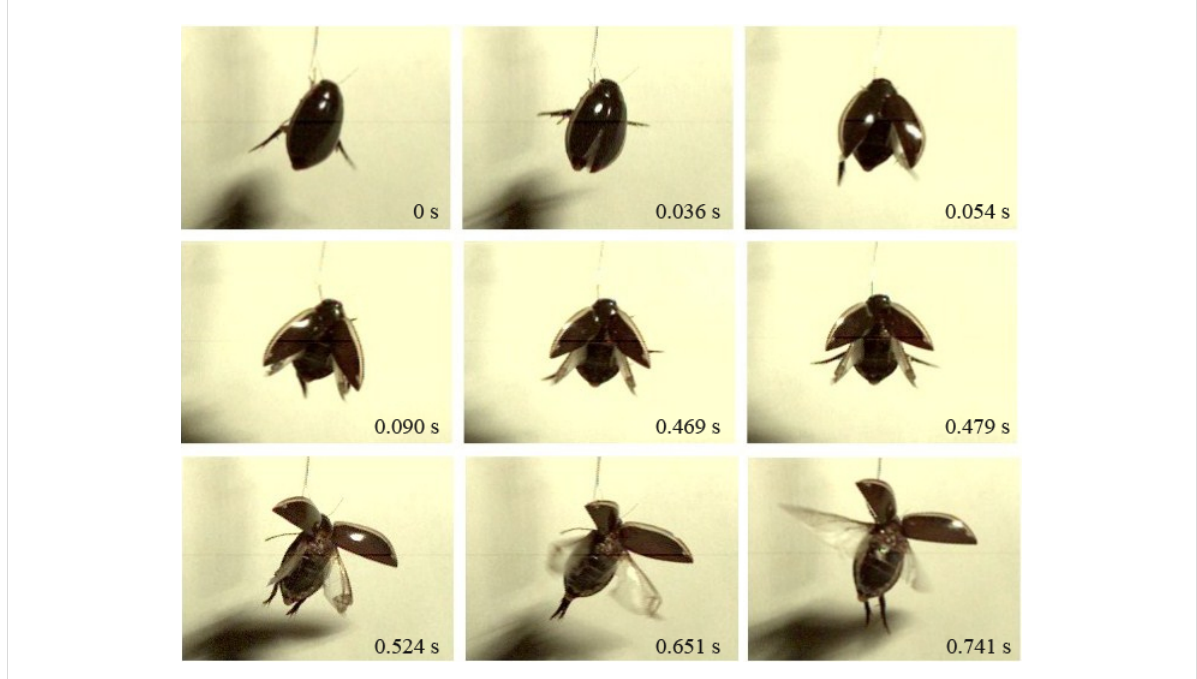
Figure 2: The unfolding process of the hind wings of C. japonicus captured by a high-speed